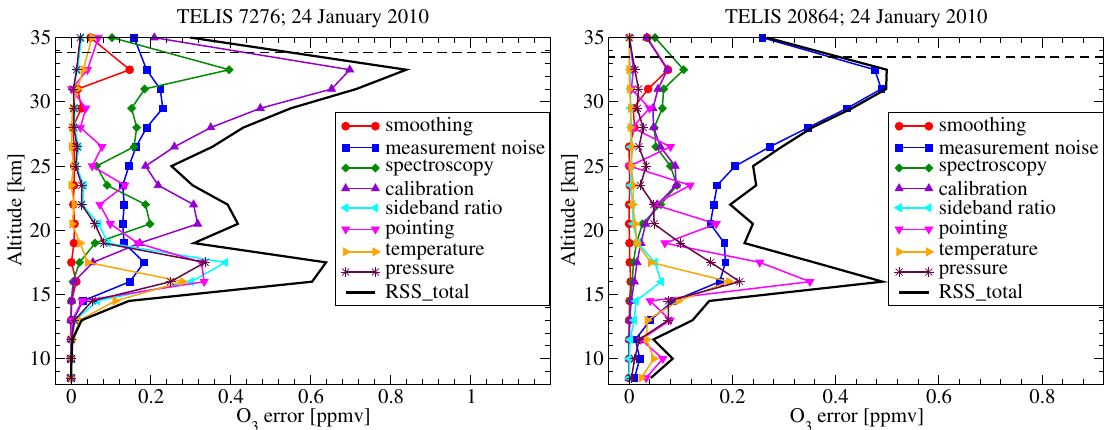
Figure 3. Individual estimates of smoothing, noise, and model parameters errors for O 3 retrieval. The estimated errors correspond to TELIS FIR measurements 7276 (HDO microwindow) and 20864 (CO microwindow) during the 2010 flight. Assumed uncertainties in the model parameter errors can be found in Table 2. The solid black line (RSS_total) refers to the total error represented by the RSS of all error components (see Equation